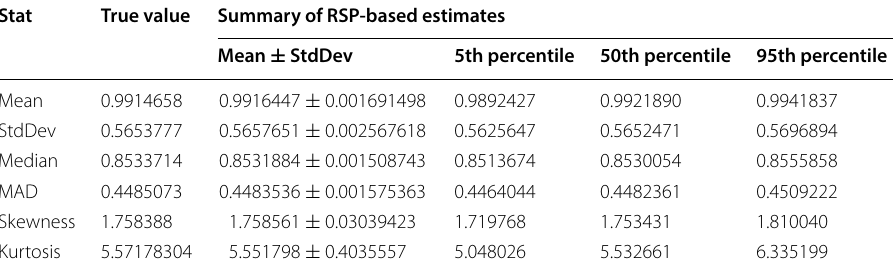
RSP-based estimates were calculated from a sample of RSP blocks ( g = 15